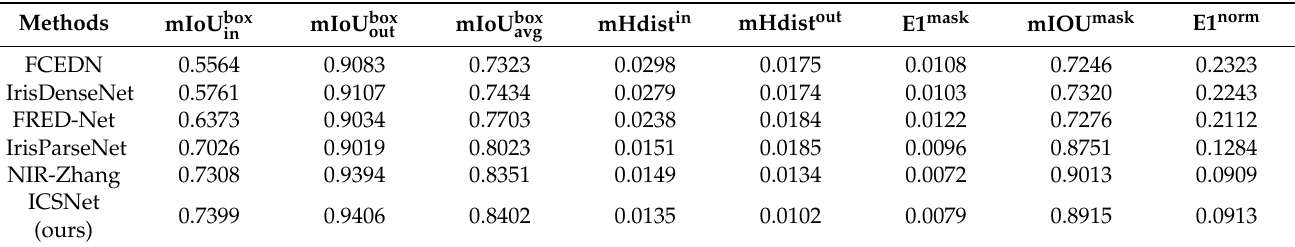
Table 2. Accuracy of iris segmentation and localization on NICE-II.